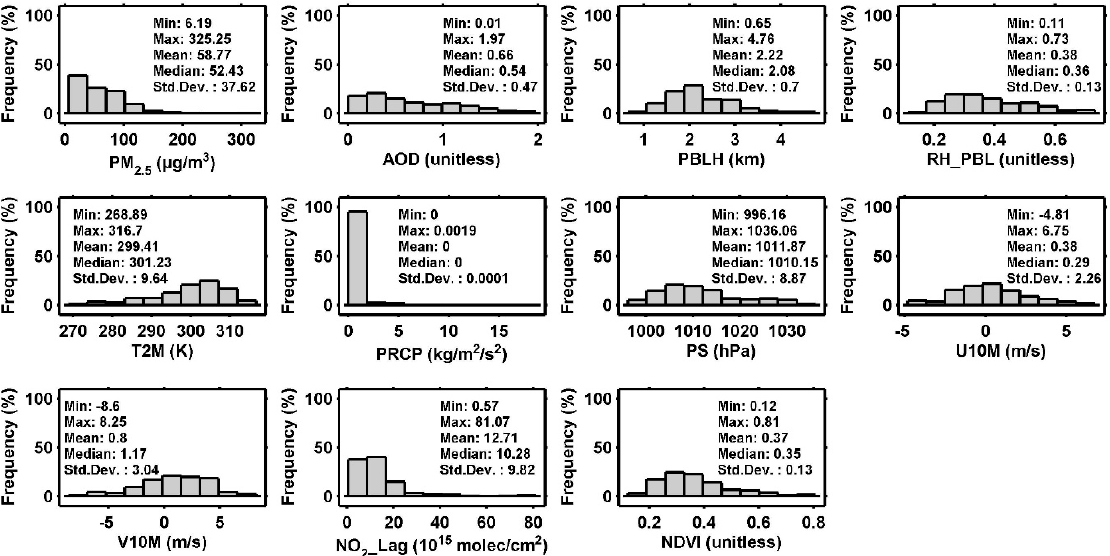
Figure 3. Histogram and descriptive statistics of all variables in the model dataset.